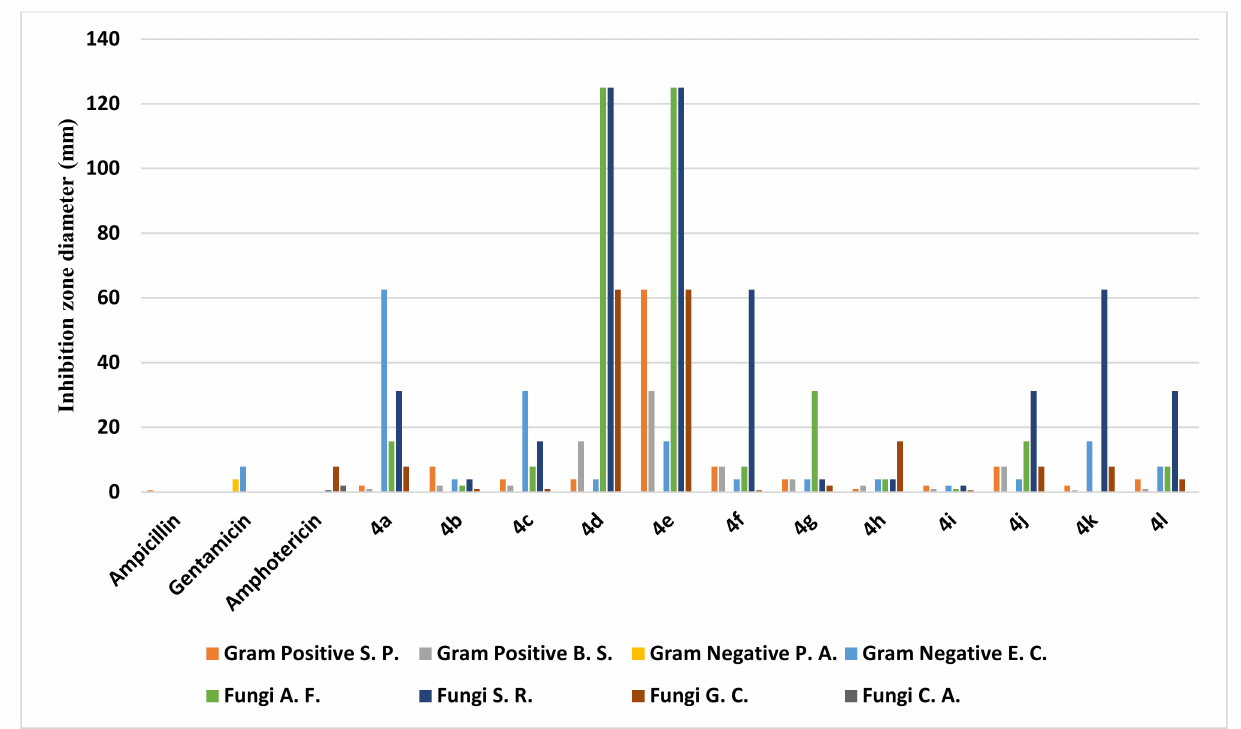
Figure 7. Evaluation of minimum inhibitory concentration values (MIC) of compounds 4a-l